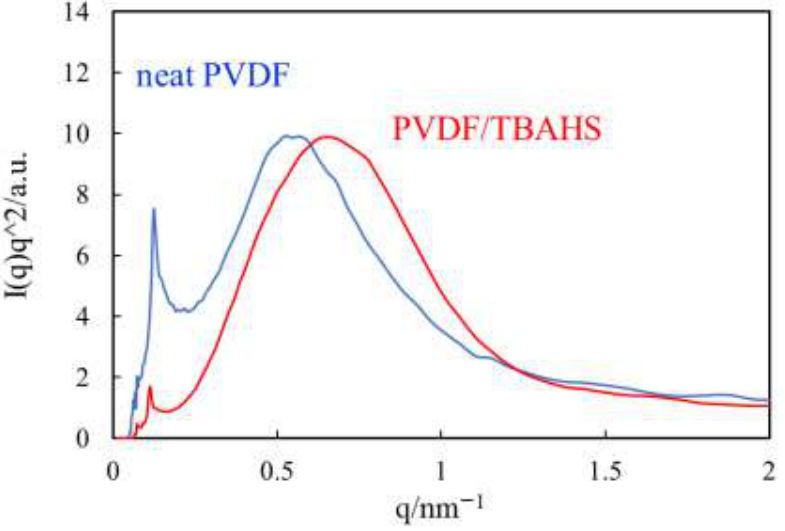
Figure 2. SAXS profiles of α -spherulite of neat PVDF and γ -spherulite of PVDF/TBAHS obtained through isothermal crystallization at 165 °C.